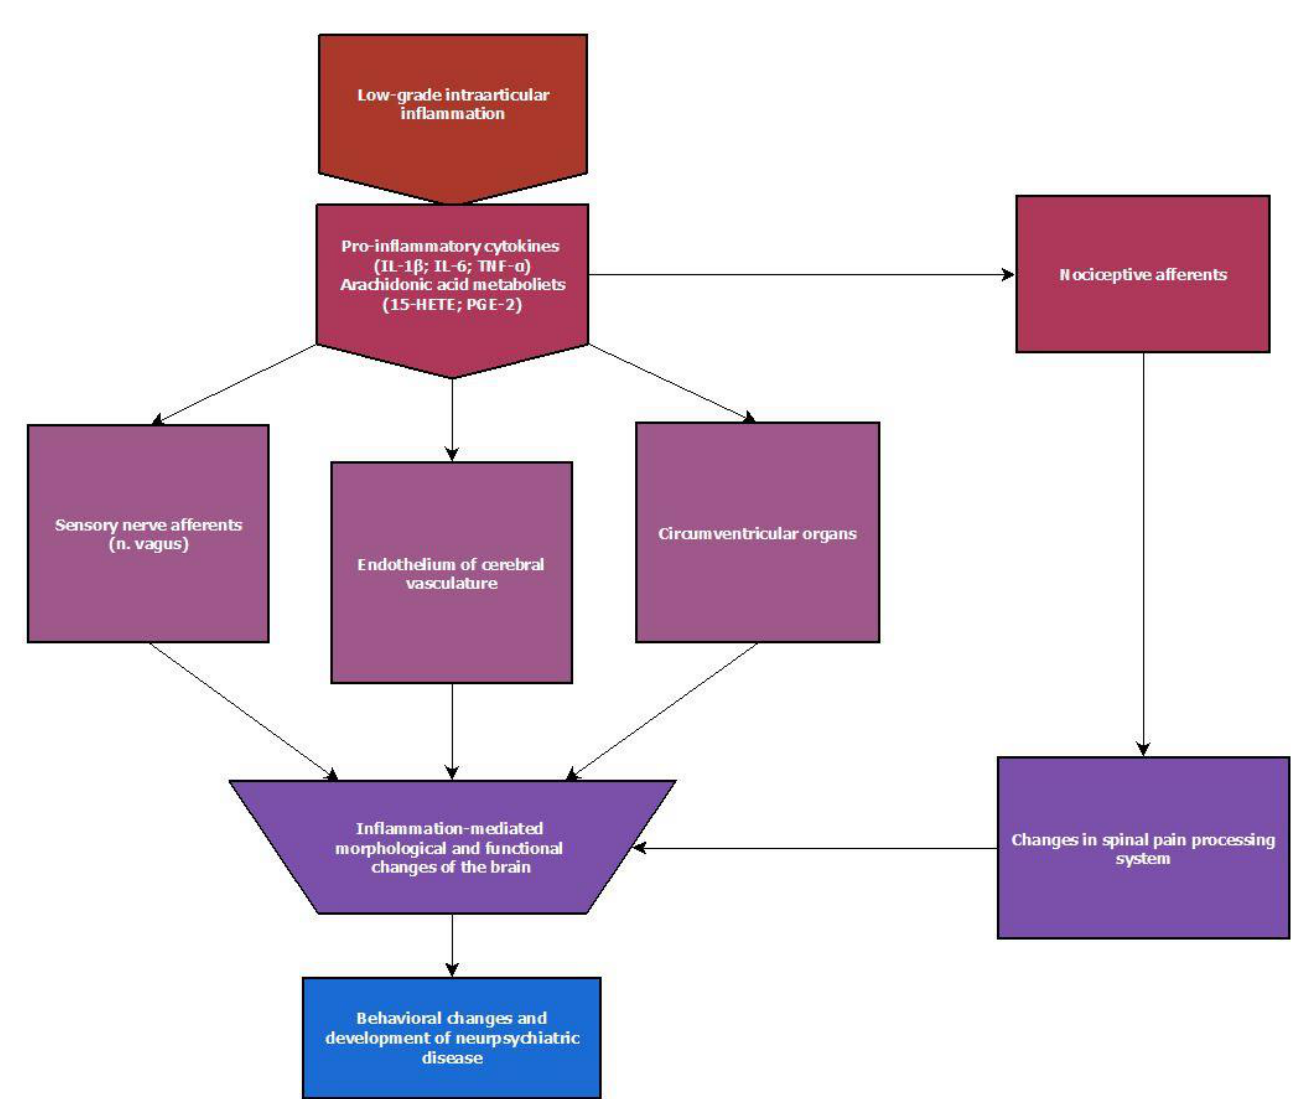
Figure 4. An outline of the main pathways for signaling inflammatory mediators to the central nerv- ous system and the sequelae of recognized routes. nervous system and the sequelae of recognized